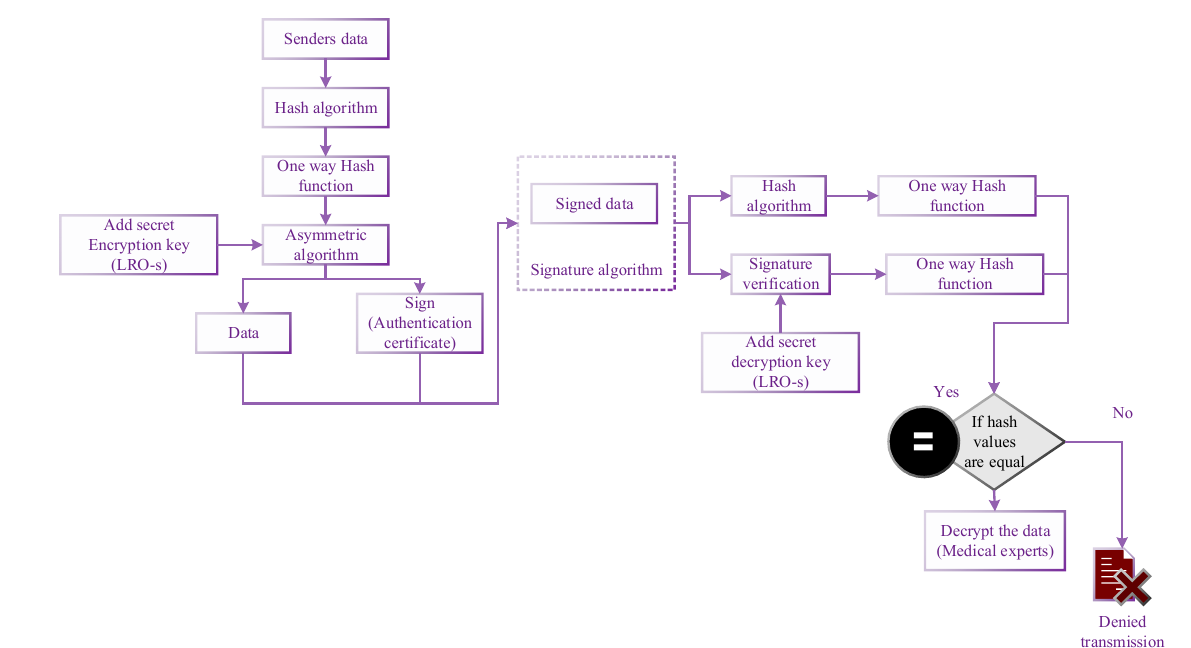
Figure 4. Flowchart of proposed Asymmetric Hash Signature.